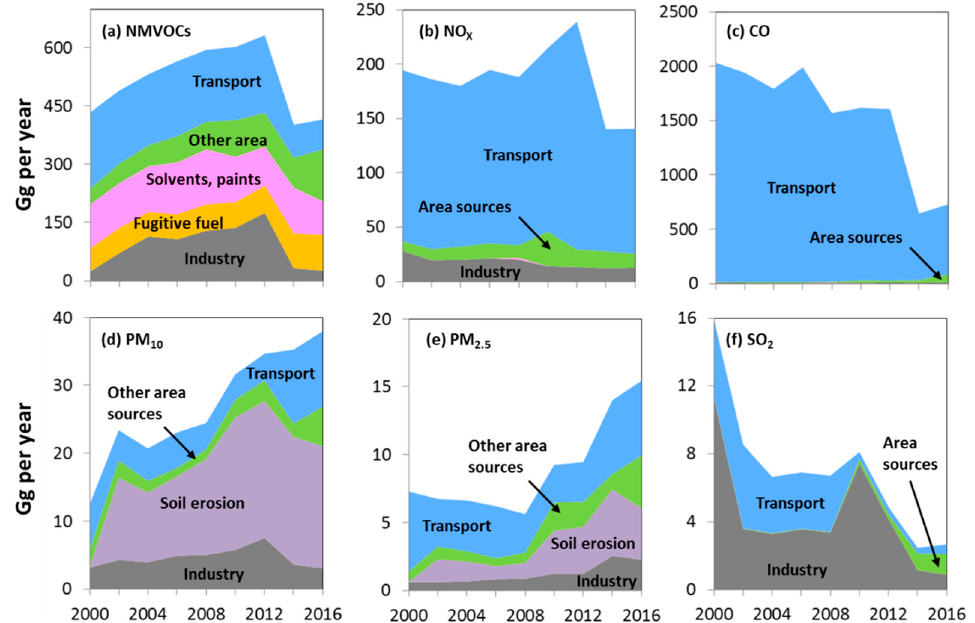
Figure 4. Emissions time series (2000–2016) by sectors for: ( a ) non-methane volatile organic compounds (NMVOCs), ( b ) NO x , ( c ) CO, ( d ) PM 10 , ( e ) PM 2.5 , and ( f ) SO 2 obtained from the official MCMA emissions inventory [25]. The emissions presented here are lumped in major sectors.